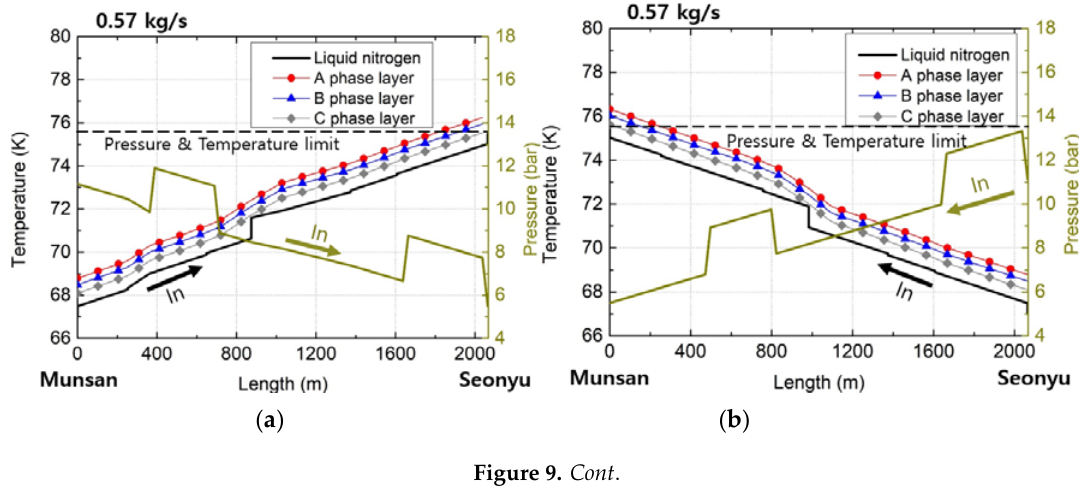
Figure 8. Allowable mas flow rates that meets the pressure limit and temperature limit for various cooling modes: ( a ) single cooling system; ( b ) dual cooling system, Munsan side; ( c ) dual cooling system, Seonyu